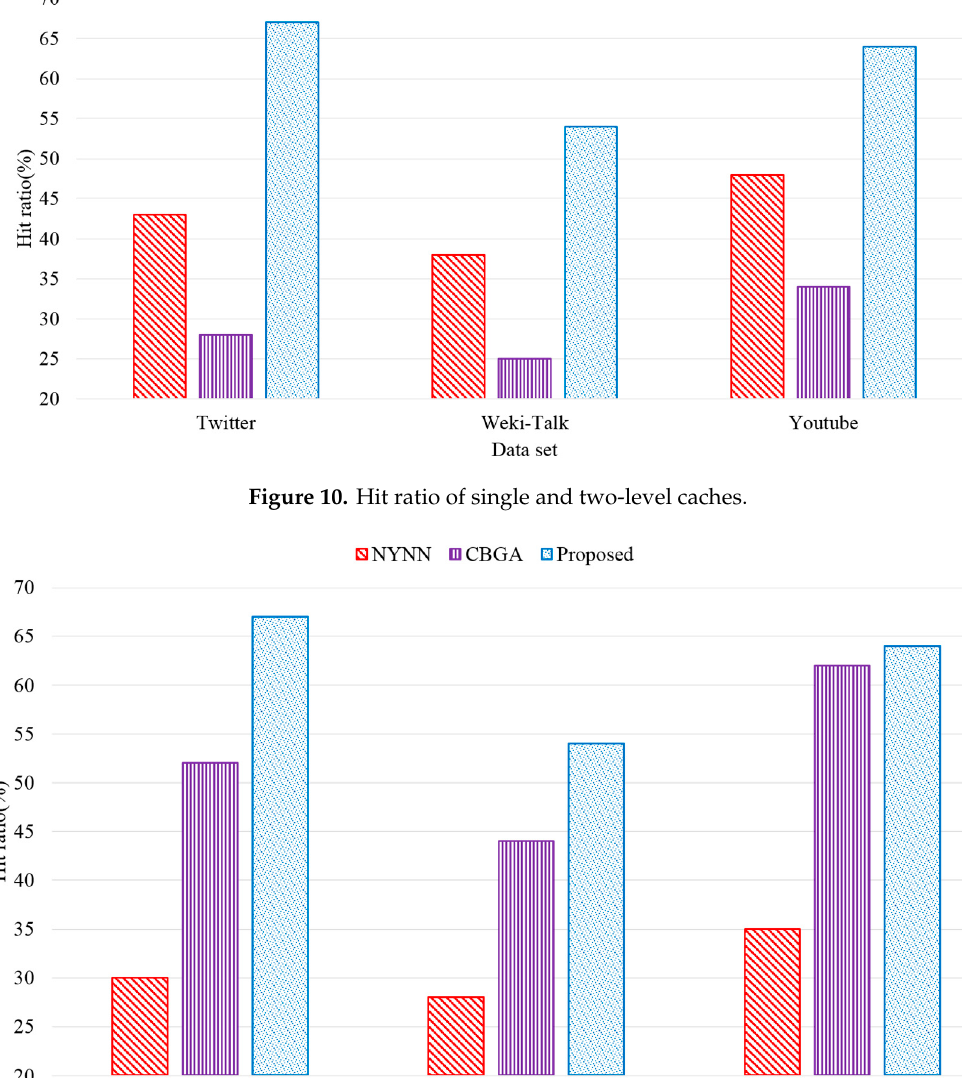
Figure 11. Hit ratio on each of the datasets.